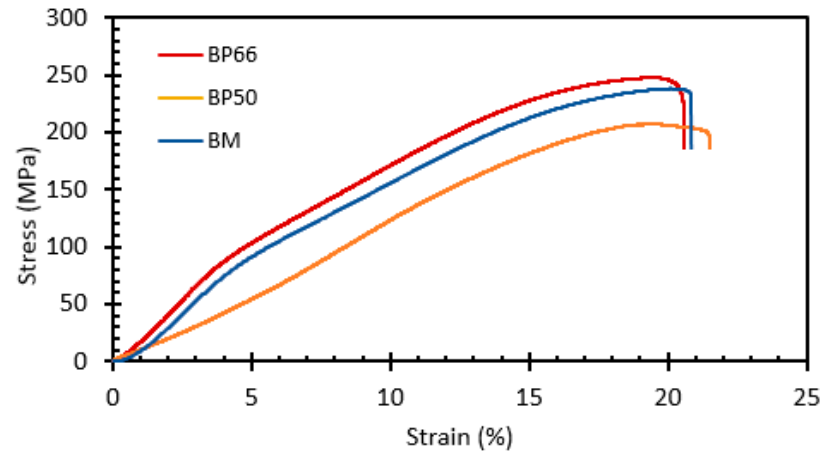
Figure 10. Compression stress–strain curves of AM60 alloy subjected to PEO coating at different conditions.